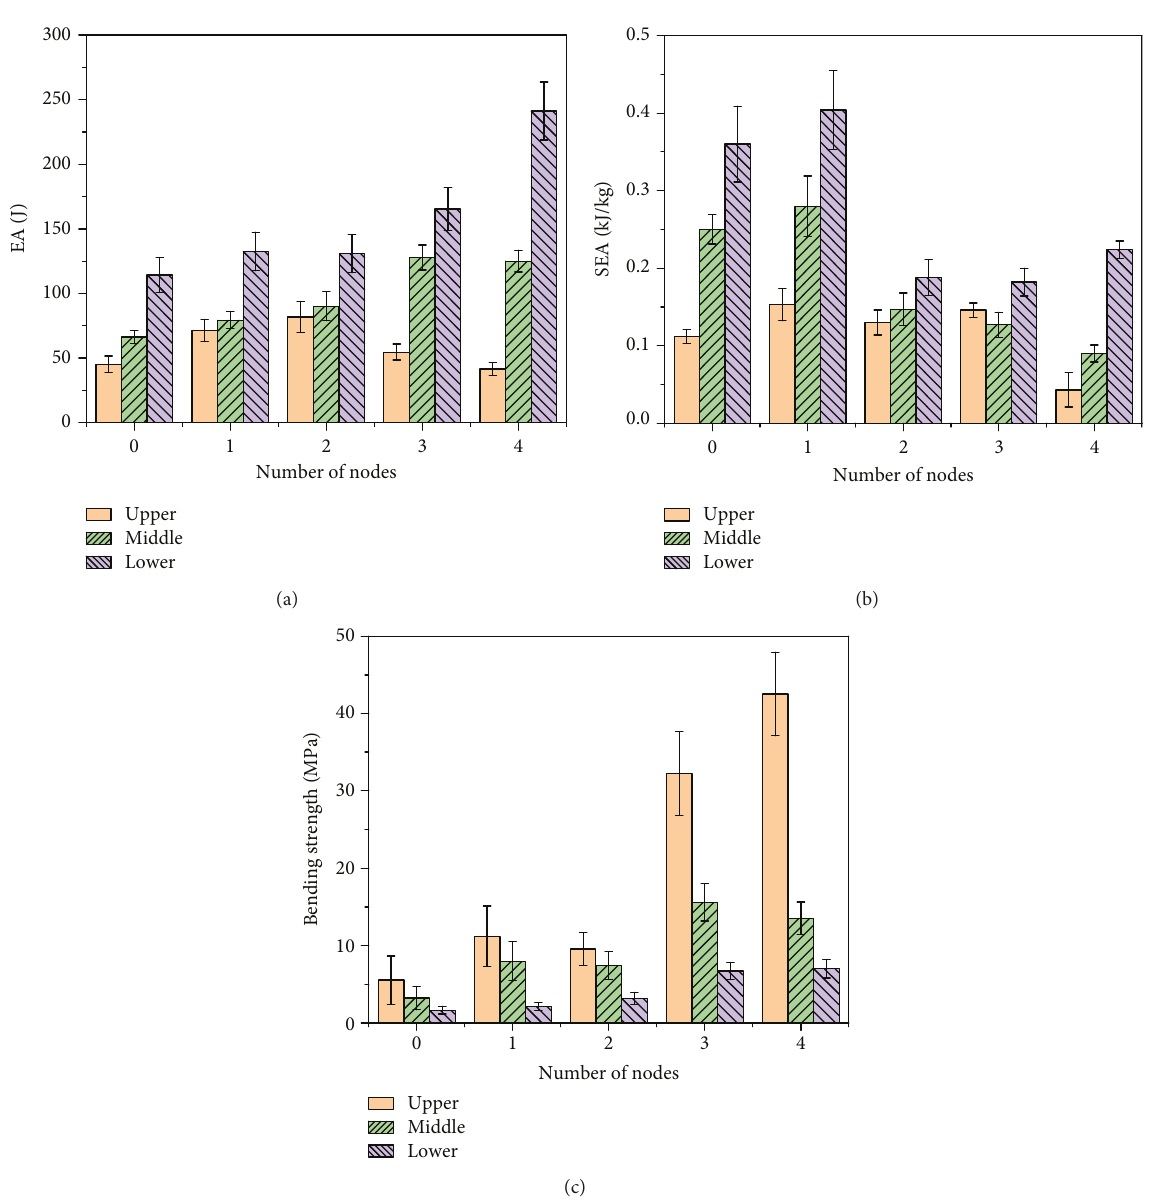
Figure 8: Mechanical properties of samples with a di ff erent number of nodes under bending load: EA, SEA, and